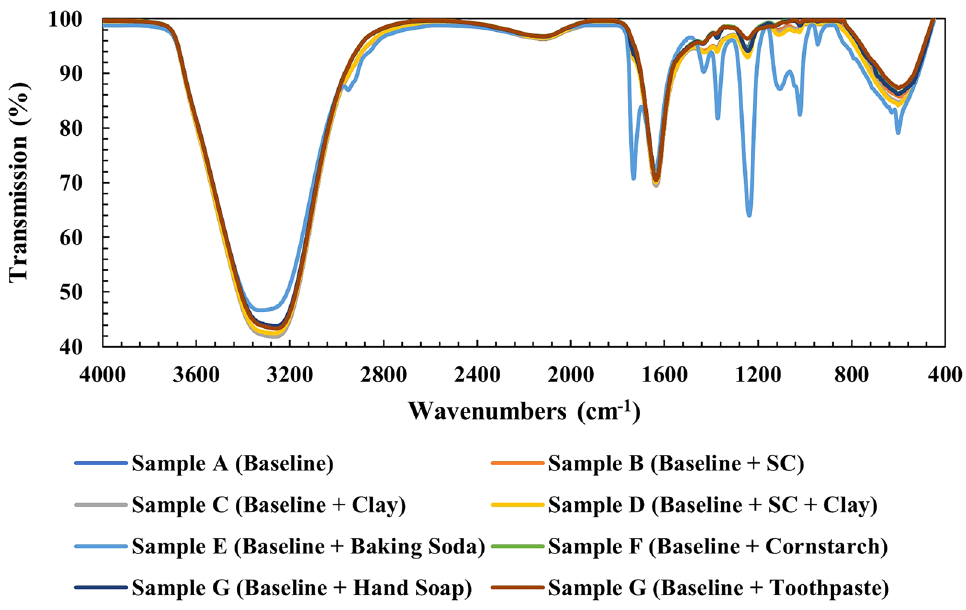
Figure 4. FT-IR spectra obtained for samples